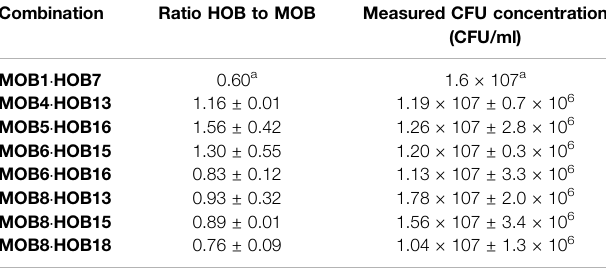
TABLE3| RatioofHOBtoMOBandmeasuredCFUconcentrationafter4 daysof incubation in a microtiter plate. Ratios were inferred from selective plating. Values of ratios are expressed as mean values ± standard deviation ( n (cid:1) 3).